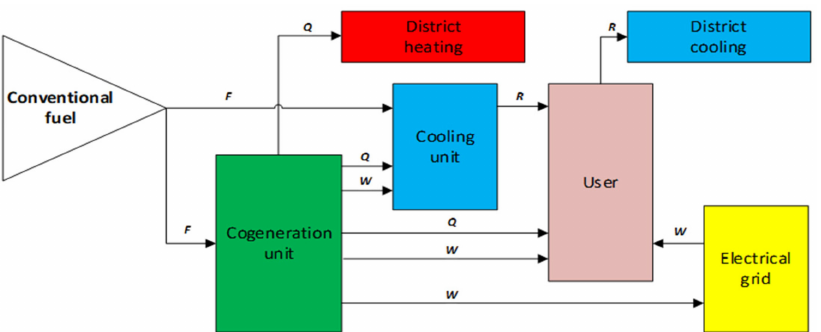
Figure 5. Trigeneration P&ID (trigeneration technological scheme and flows of the energy). F -fuel thermal content (kWht); Q -heat (kWht); R -cooling (kWht); W -electricity